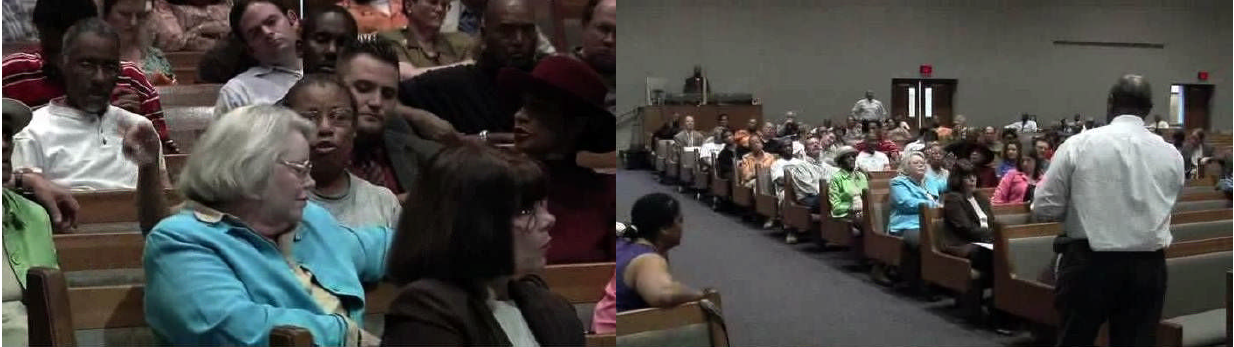
Figure 14: Final sequence with Lady, Dick Davis, and Woman [start 39:01 – end